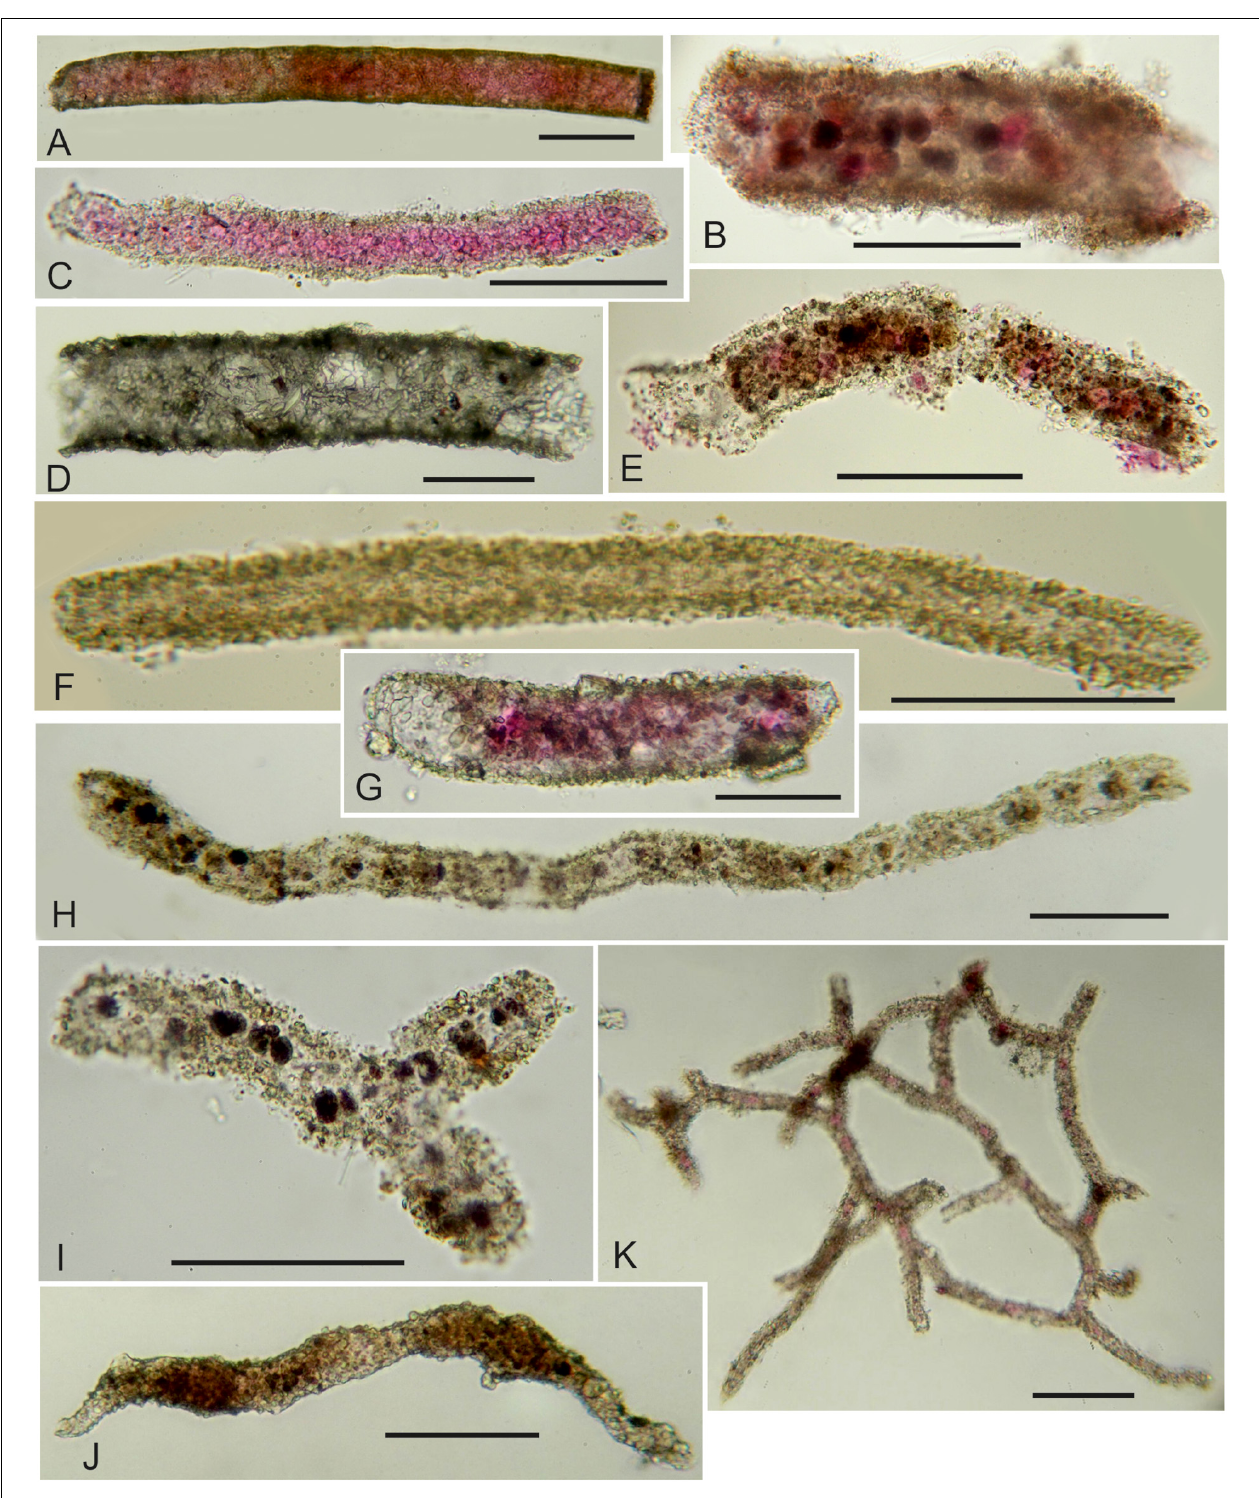
FIGURE 3 | (A–F) Undescribed tubular foraminifera (fragments unless stated otherwise). (A) Stained; MC21, 0.5–1.0 cm, 63–125 µ m fraction. (B) Stained with stercomata; MC13, 0–0.5 cm, 125–150 µ m fraction. (C) Stained; MC11, 0–0.5 cm, 63–125 µ m fraction. (D) Dead; MC13, 0–0.5 cm, 125–150 µ m fraction. (E) Stained; MC09, 0–0.5 cm, 63–125 µ m fraction. (F) Dead; MC21, 0.5–1.0 cm, 63–125 µ m fraction. (G) Stained, complete test; MC05, 0.5–1.0 cm, 63–125 µ m fraction. (H) Dead tubular fragment with stercomata; MC11, 0–0.5 cm, 63–125 µ m fraction. (I) C omplete tubular specimen; MC11, G, 0–0.5 cm, 63–125 µ m fraction. (J) Marsipella sp.; MC11, 0–0.5 cm, 63–125 µ m fraction. (K) Stained fragment of Reticulum (komokiacean); MC13, 0–0.5 cm, 125–150 µ m fraction. Scale bars = 100 µ